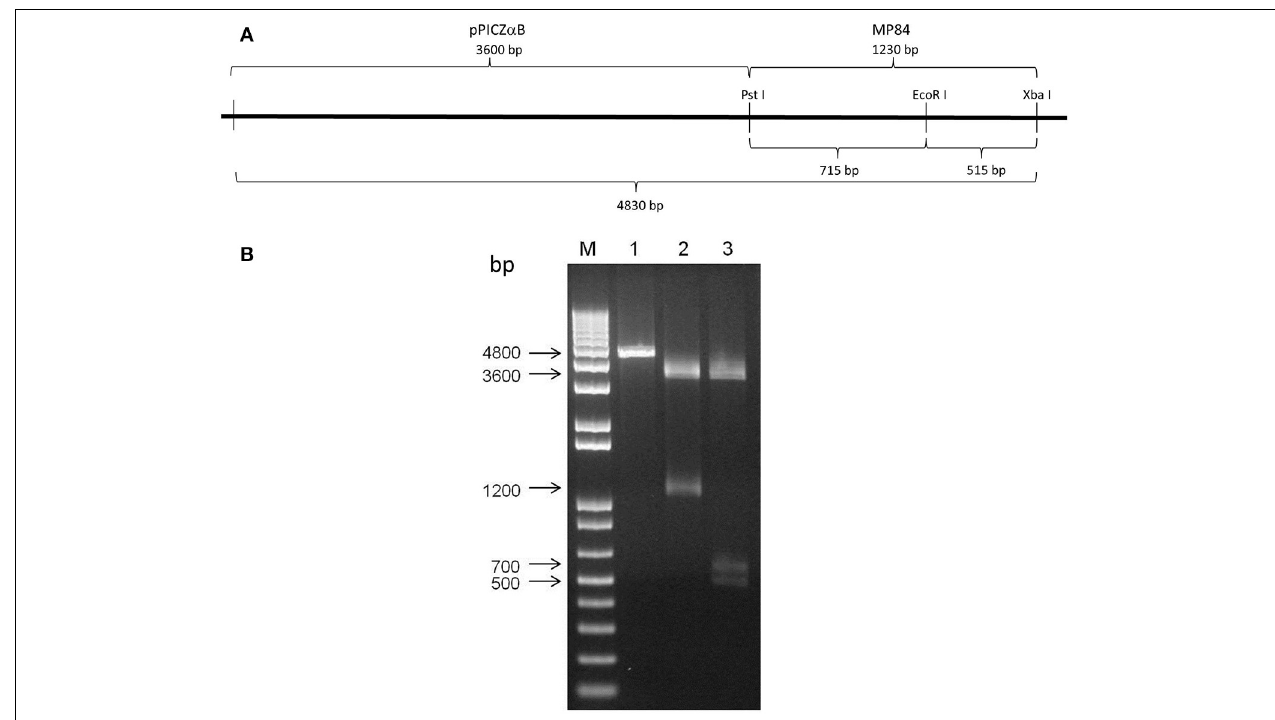
FIGURE 2 | Cloning of MP84 mannoprotein in pPICZ α B plasmid. The amplified gene of MP84 by PCR was ligated in expression vector pPICZ α B and then transformed into E. coli DH5 α . After the selection of the positive clones, the plasmids were extracted and the differential digestion was